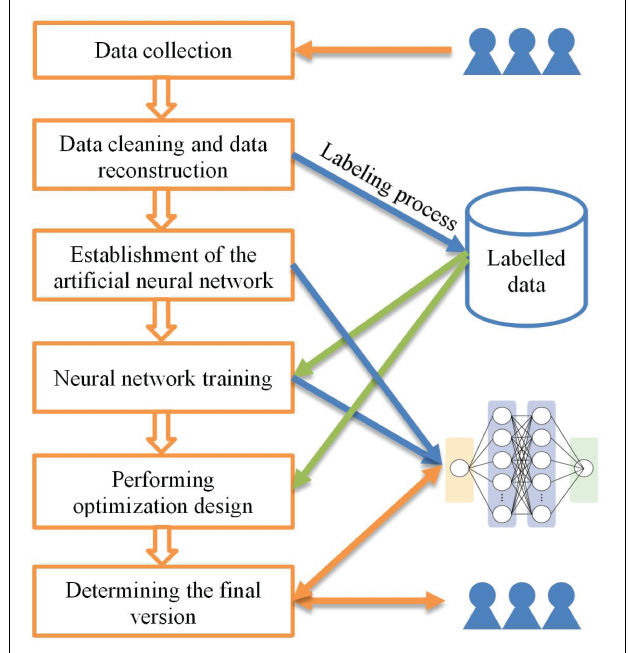
FIGURE 1 | Flowchart of the proposed AIAD